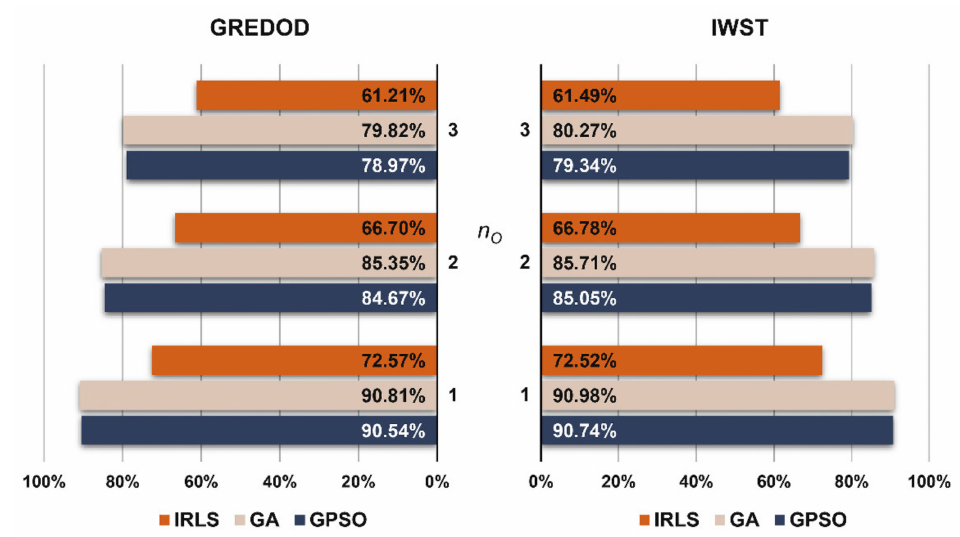
Figure 6. Overall efficiency of GREDOD and IWST methods.